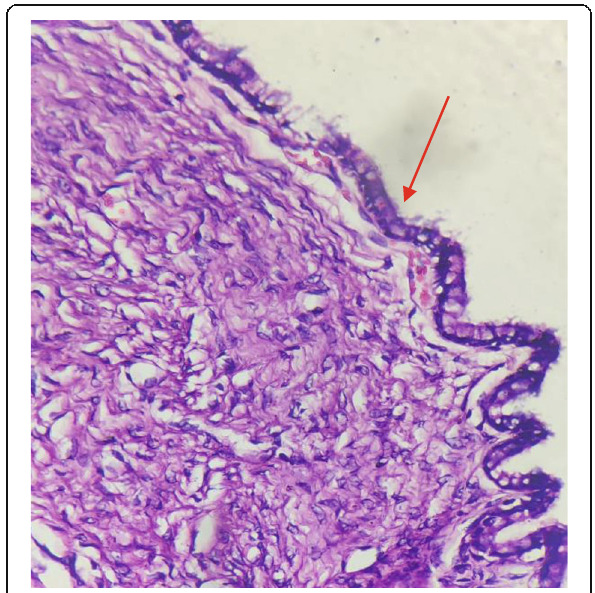
Fig. 3 Showing Hematoxylin and Eosin (magnification 400x) photomicrographs of a Mucinous Cystadenoma showing a cyst wall with lining epithelium composed of benign looking goblet cells (red arrow) with collagenised stroma